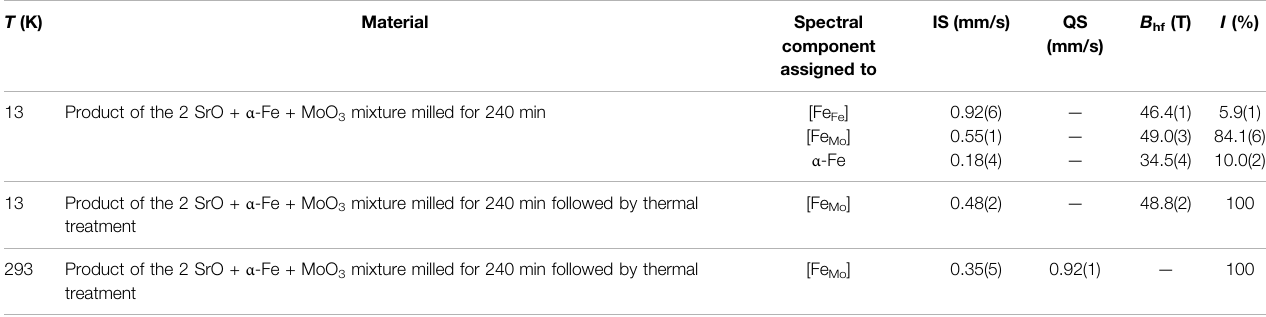
TABLE 1| Parametersobtainedby fi tting 57 FeMössbauerspectratakenat 13and 293 Kforthe2SrO+ α -Fe+MoO 3 mixture milledfor240 minbeforeand afterits thermal treatment. IS isthe isomer shift; QS is the quadrupole splitting; B hf isthe magnetic hyper fi ne fi eld; I isthe relativeintensity ofthe spectral component. Symbols [Fe Fe ] and [Fe Mo ] denote iron cations in octahedral coordination of oxygen anions in the ordered and anti-site disordered regions of Sr 2 FeMoO 6 , respectively. Material Spectral component assigned